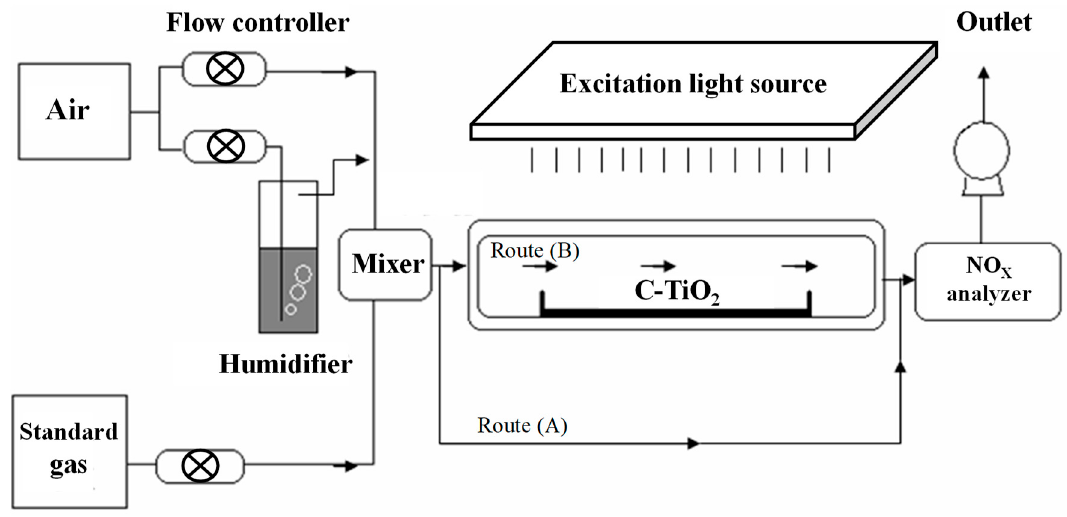
Figure 14. Schematic drawing of continuous reaction system for photocatalytic degradation of nitrogen oxides.